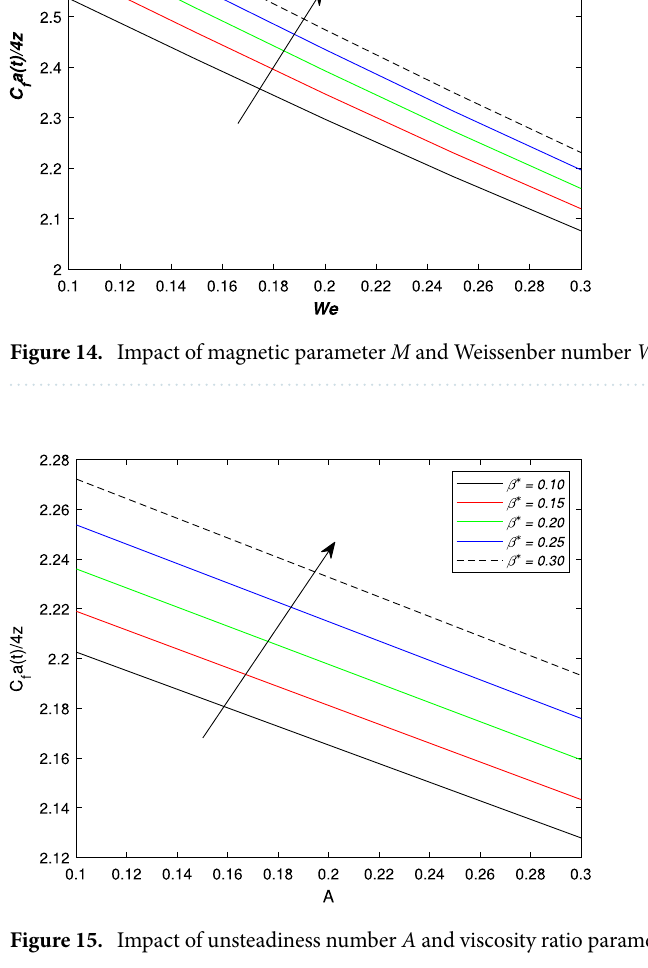
Figure 15. Impact of unsteadiness number A and viscosity ratio parameter β ∗ on skin friction coefficient.